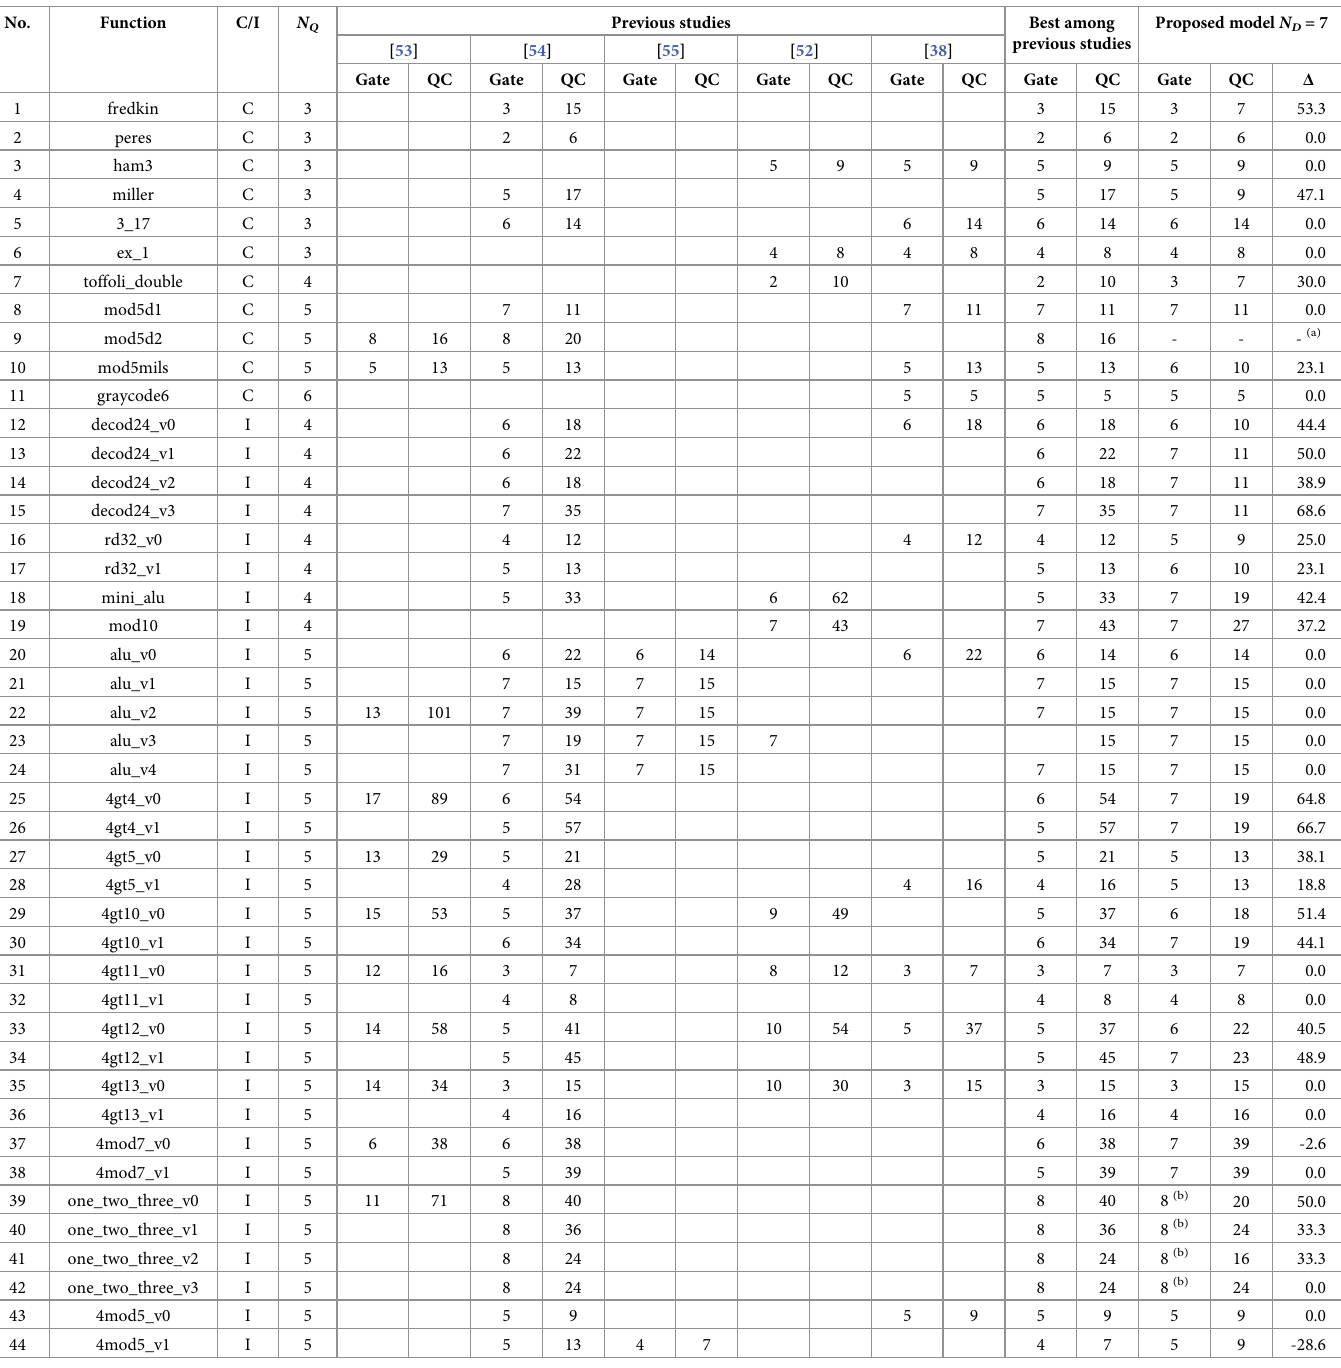
Table 8. Comparison of computational results with those of previous